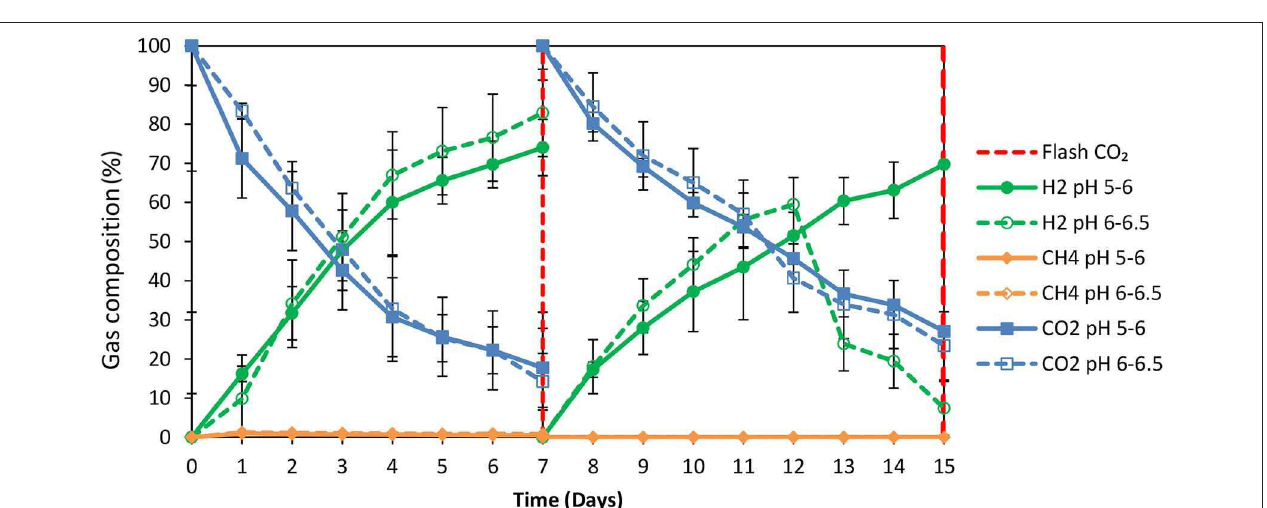
operated at pH 5–6. These findings points out that the